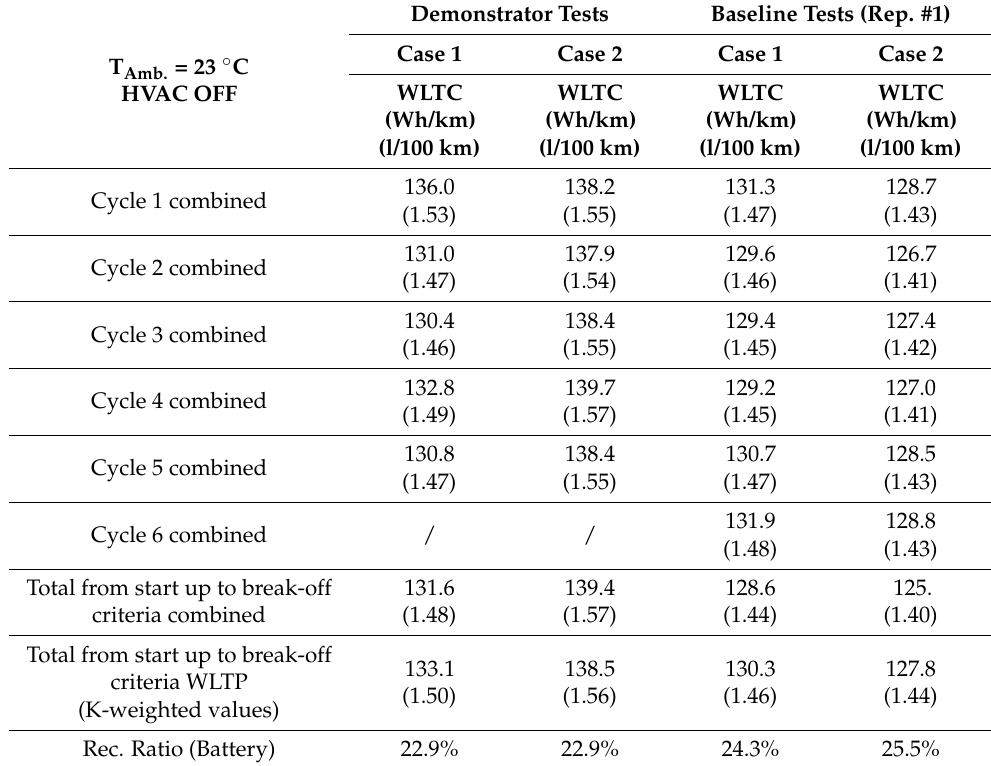
Table 4. Energy consumption results for the WLTP CCT at 23 ◦ C for the baseline [14] and the demonstrator vehicle. Results for the two measurement cases (Case 1—CAN current and CAN voltage measurements; Case 2—AC/DC clamp for current and CAN voltage